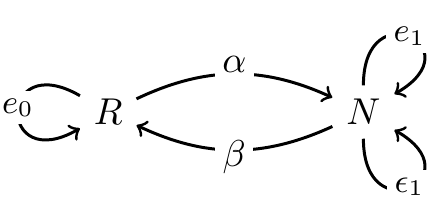
Figure 8. The NCCR of R = C [ x; y; z; t ] = (5.10). N is a rank-two CM (corresponding to